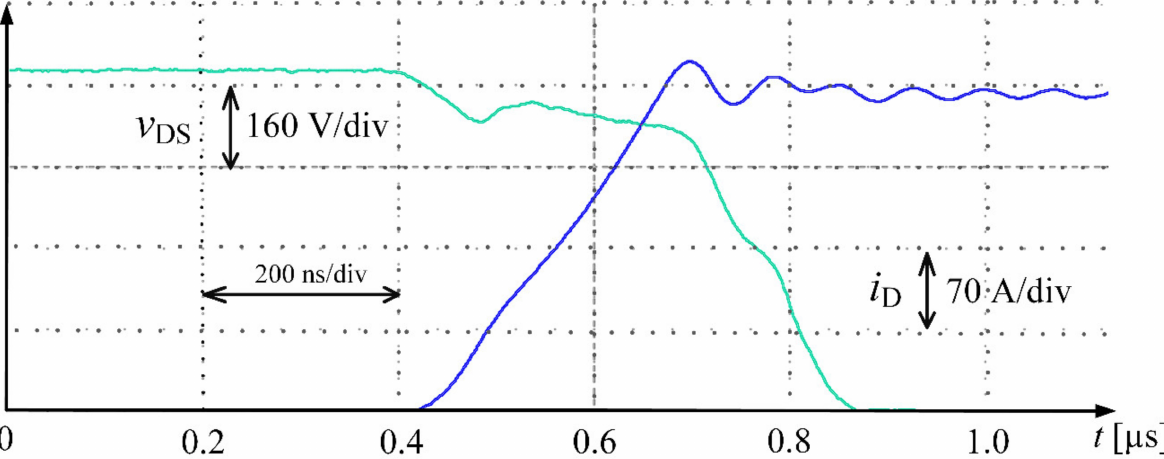
Figure 11. The turn-on cycle of the SiC MOSFET from module CAS300M17BM2 with AGD. V DD = 700 V, I 0 = 270